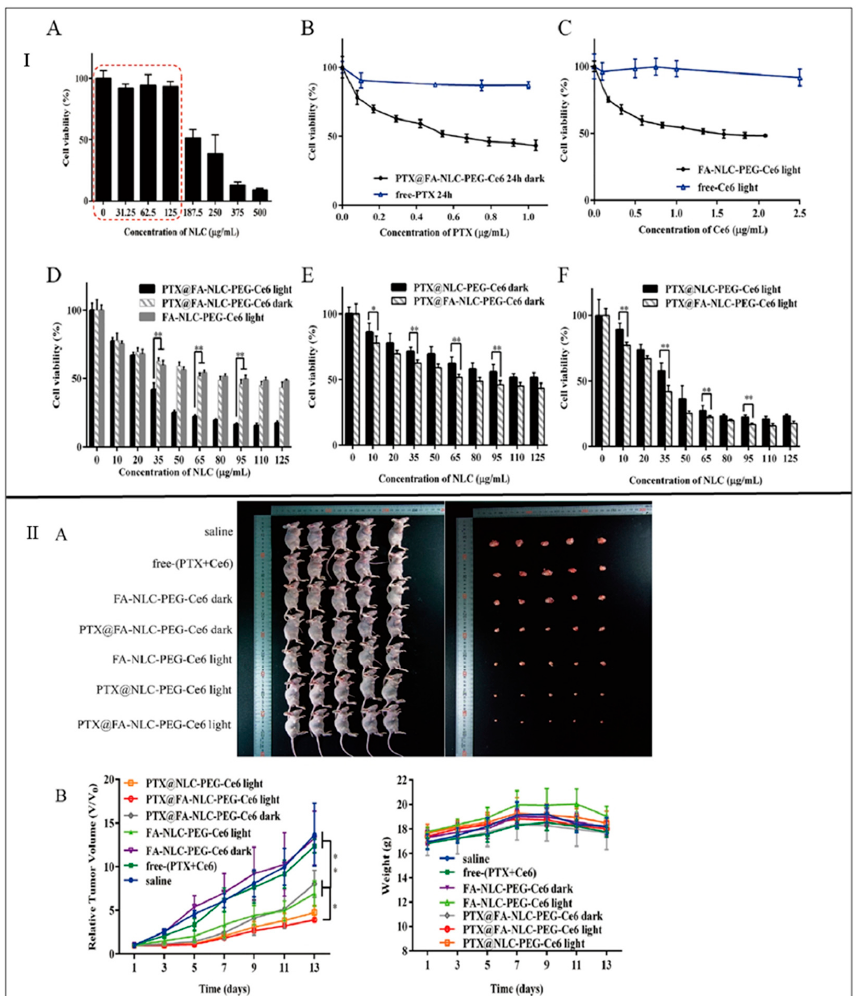
Figure 5. ( I ) In vitro cytotoxicity assays: ( A ) Cell viability of MDA-MB-231 cells after incubation with FA-NLC-PEG-Ce6 (dark) NPs of different concentrations. ( B ) Cytotoxicity evaluation of free-PTX